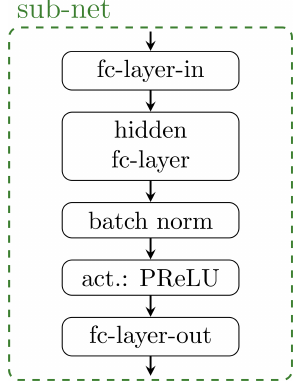
Figure 5. Sub-network with one hidden fully connected layer (fc- layer), batch normalization, and a PReLU activation layer. Each conditional coupling block (CC) has such a sub-network embedded.